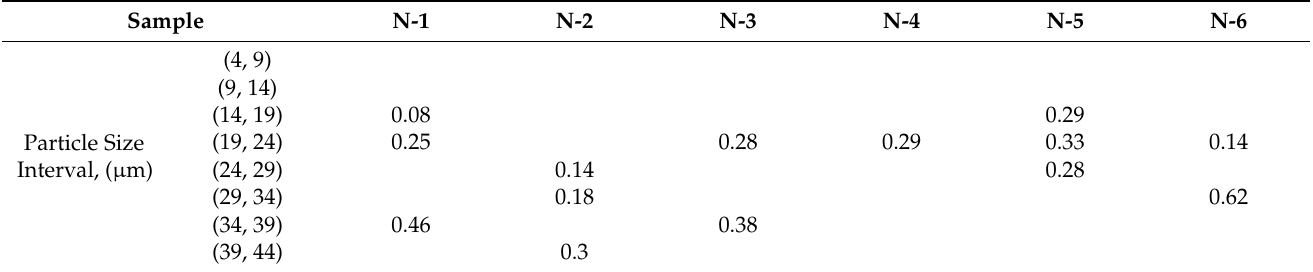
Table 3. Image-based quantification of “elongated” quartz (unit: %; on the bulk area).